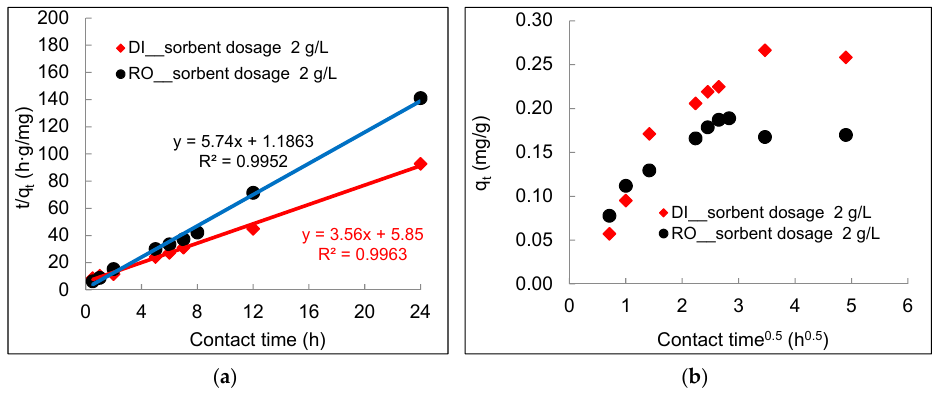
Figure 3. Kinetic studies of arsenic sorption at DWTS dosage of 2 g/L at pH 7 and 23 °C. ( a ) Pseudo-second-order sorption model; ( b ) Intra-particle diffusion kinetic model. Table 1. Pseudo-second-order sorption constants of arsenic onto DWTS.